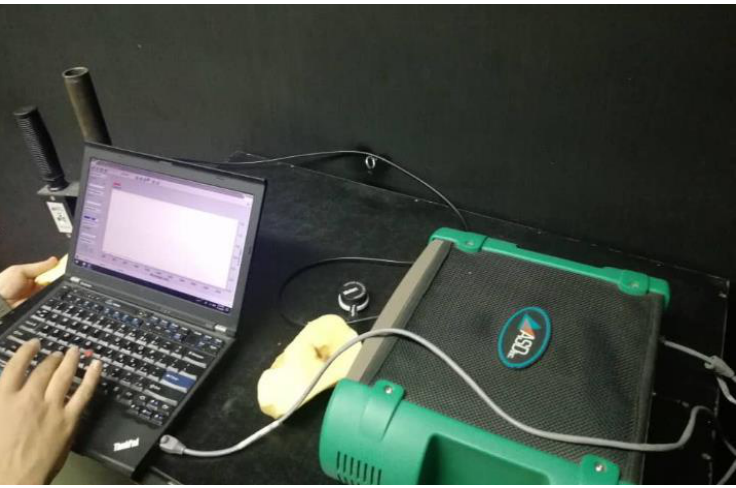
Figure 3. Hardware configuration for obtaining spectral data of the potato samples.